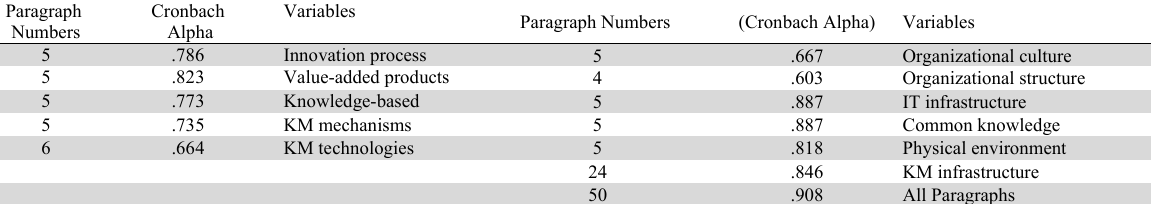
Values of coherence coefficient (Cronbach Alpha) for the paragraphs of the study